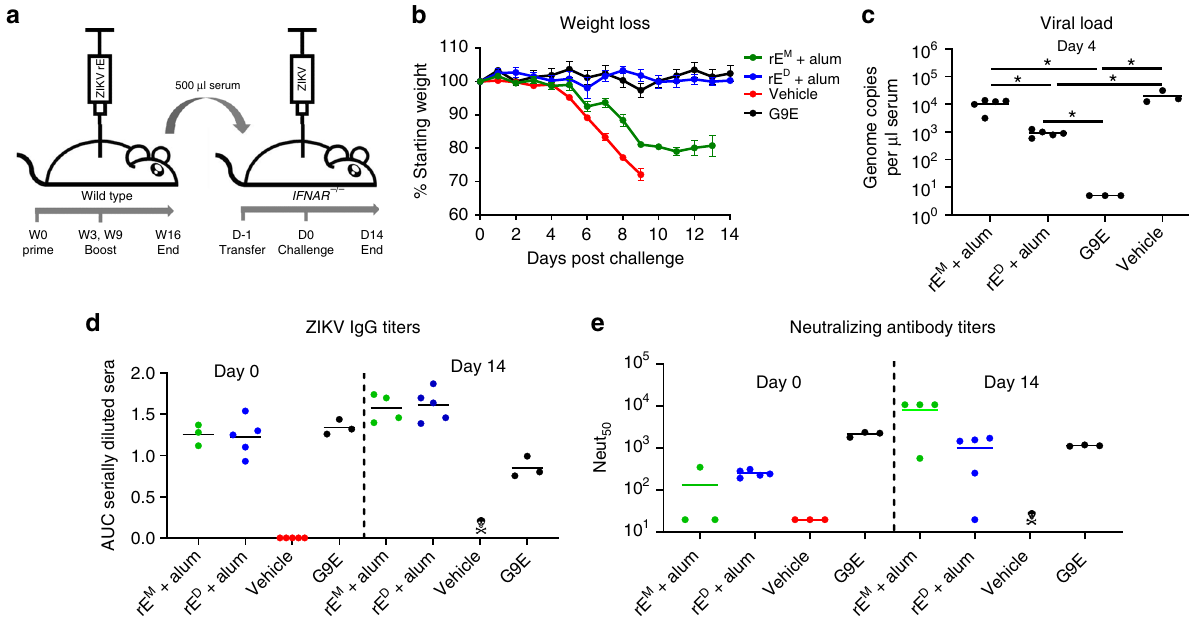
Fig. 4 ZIKV rE D induce protective antibodies in mice. a Wild-type mice were immunized with rE M + alum or rE D + alum. Five hundred microliters of heat- inactivated immune sera (16 weeks post immunization) (or 200 µ g of neutralizing mAb G9E) was transferred by intraperitoneal injection to Ifnar1 − / − mice 24 h prior to challenge with 1000 FFU of ZIKV by subcutaneous footpad inoculation ( n = 5 for rE M and rE D and n = 3 for controls). b Challenged mice were weighed daily for 14 days; weights are shown percent of starting weight. Data represent the mean + / − SEM of 3 – 5 mice per group and were censored